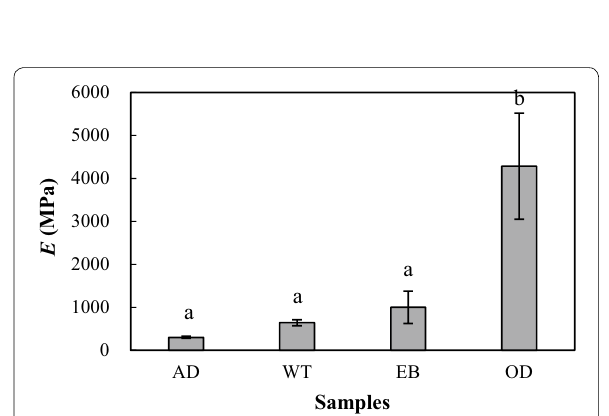
Fig. 9 Young’s modulus ( E ) of specimens in the compressive fluidity tests. Means with the same letter (a, b) are not significantly different (Tukey–Kramer test, p < 0.01) ( n